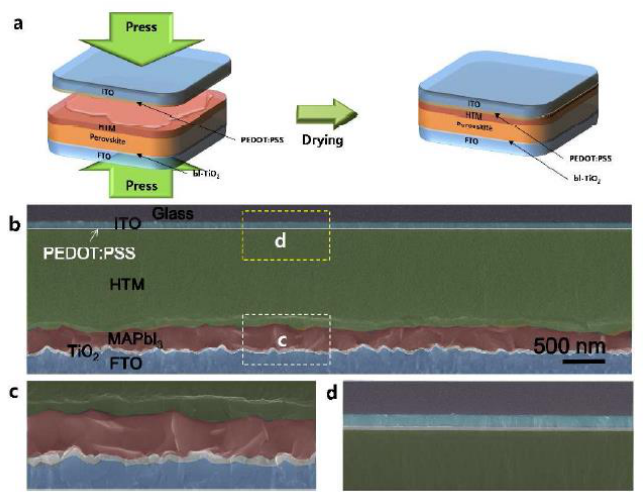
Figure 7. ( a ) MAPbI3 planar sandwich solar cell schematic illustration for device fabri- Figure 7. (a) MAPbI3 planar sandwich solar cell schematic illustration for device fabrication and 393 cation and architecture, ( b ) A typical SEM cross-sectional image of a complete sandwich architecture, (b) A typical SEM cross-sectional image of a complete sandwich cell included 394 cell included FTO/TiO2/MAPbI3/HTM/PEDOT:PSS/ITO/Glass and its enlarged image of FTO/TiO2/MAPbI3/HTM/PEDOT:PSS/ITO/Glass and its enlarged image of (c) 395 FTO/TiO2/MAPbI3/HTM part and (d) HTM/PEDOT:PSS/ITO/Glass part. [Ref. 106]. 396 ( c ) FTO/TiO2/MAPbI3/HTM part and ( d ) HTM/PEDOT:PSS/ITO/Glass part